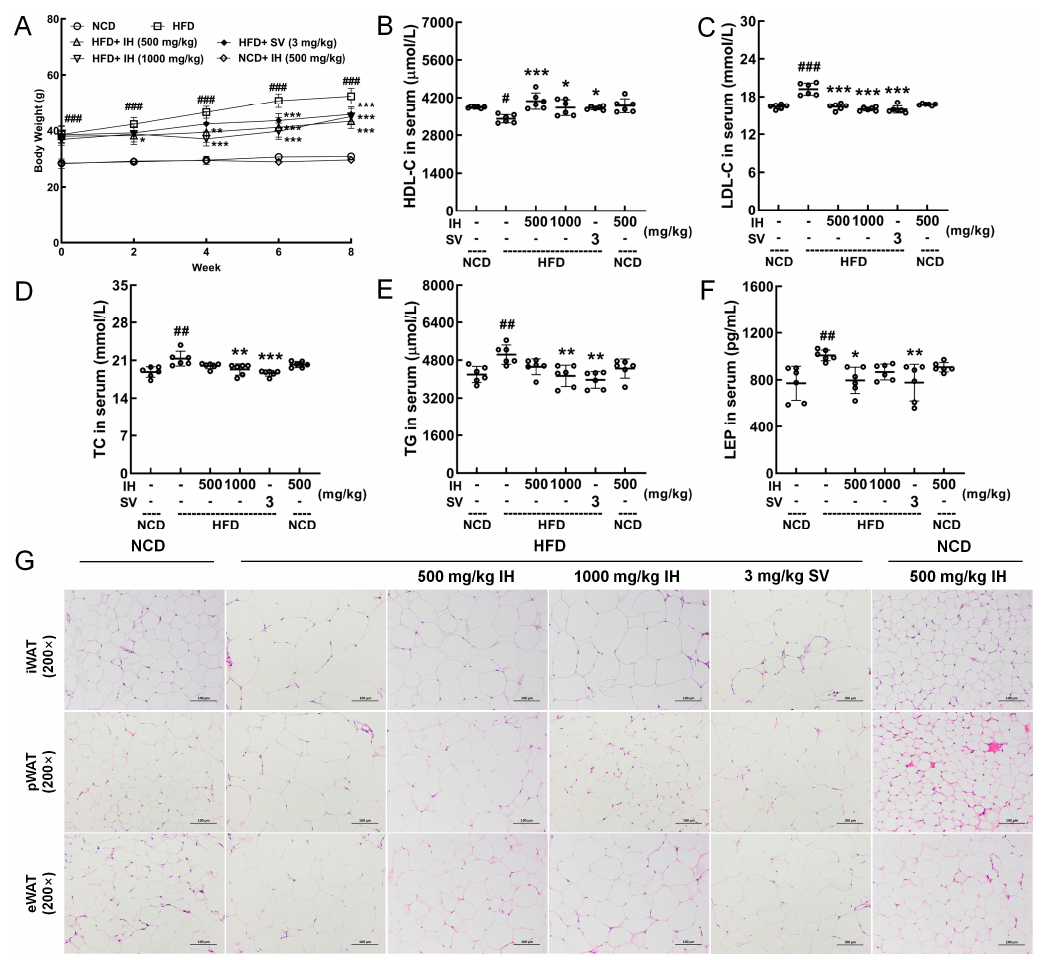
Figure 1. IH suppressed HFD-induced obesity and hyperlipidemia. ( A ) IH inhibited body weight gain in HFD mice ( n = 6). IH administration increased the level of ( B ) HDL-C and decreased the levels of ( C ) LDL-C, ( D ) TC, ( E ) TG, and ( F ) LEP in the serum of HFD-fed mice. ( G ) H&E staining of iWAT, pWAT, and eWAT (200 × ; scale bar: 100 µ m). Data were analyzed using a one-way ANOVA and expressed as the means ± SD. # p < 0.05, ## p < 0.01, and ### p < 0.001 versus vehicle-treated NCD-fed mice; * p < 0.05, ** p < 0.01, and *** p < 0.001 versus vehicle-treated HFD-fed mice. Table 2. The effects of IH on plasma glucose and organ